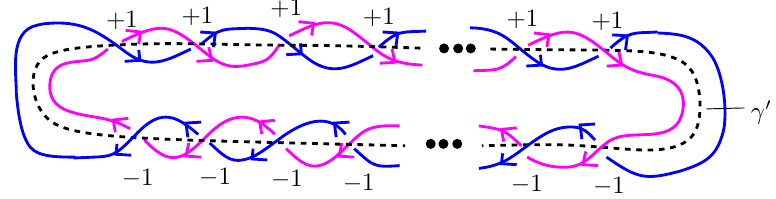
Since lk( S (cid:48) 1 , S (cid:48) 2 ) = 0 and Wr( γ (cid:48) ) = 0 , Tw( S 1 , S 2 ) is cancelled by the opposite twistings induced from the writhe. The negative twistings come from the writhe Wr( γ ) .